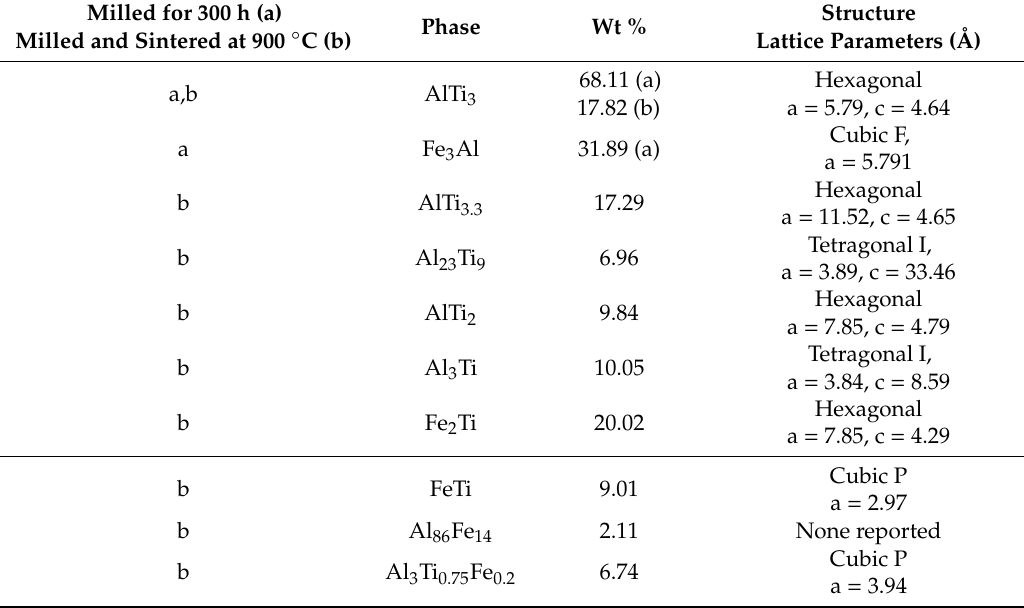
Table 2. Percentage by weight of phases in samples milled for 300 h and milled for 300 h and sintered at 900 ◦ C for 1 h.